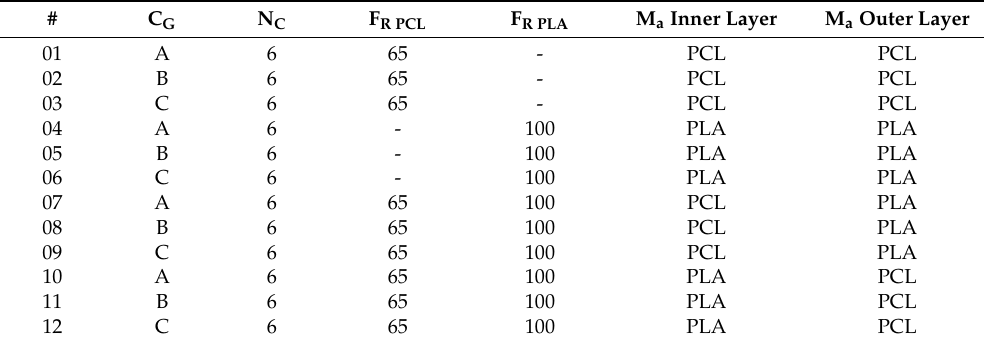
Table 3. PCL/PLA Composite stent fabrication parameters* .